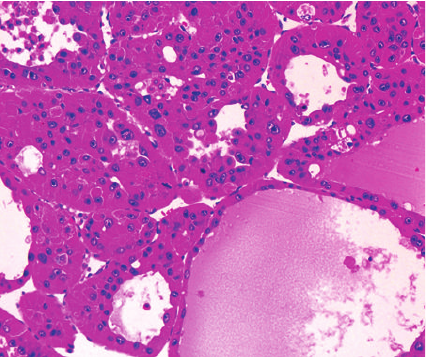
Figure 1: A case of combined HCC (brown cut surface) and FLC (lobulated grey white cut surface)—right hepatectomy specimen. Figure 2: HCC showing tumor cells arranged in pseudoglandular and trabecular pattern, hematoxylin-eosin 200x.